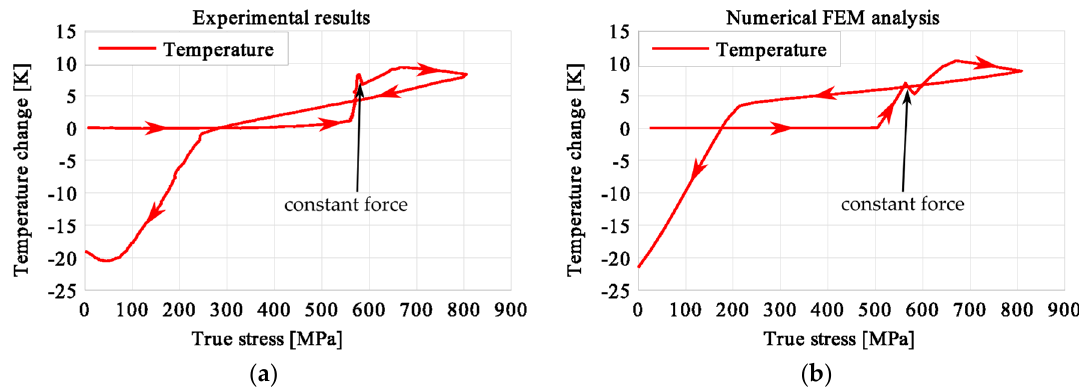
Figure 14. Temperature variations vs. stress for the loading program (1): 3-min loading interruption at the beginning of LMT: ( a ) experimental; ( b ) numerical results.